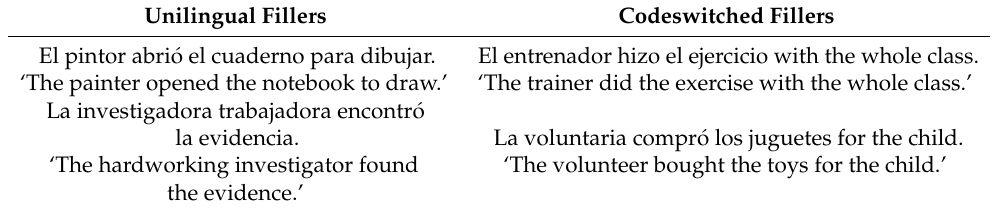
Table 3. Example Filler Items.